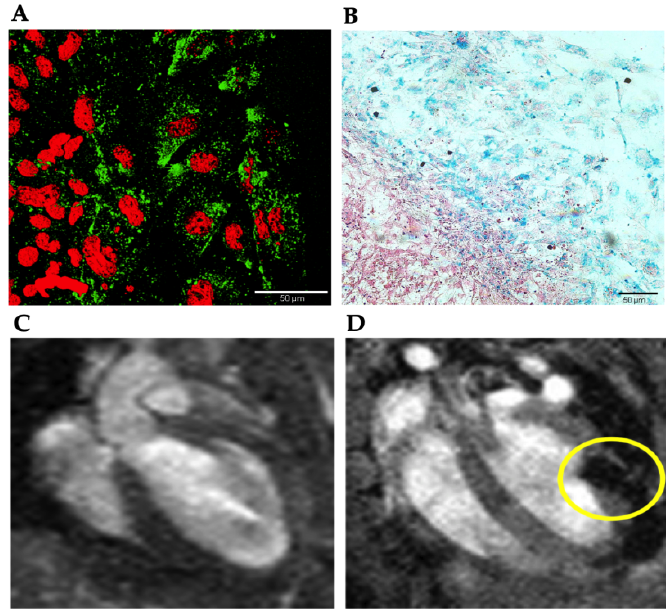
Figure 5. Detection of FeraTrack-labeled CM-mESC. ( A ) Micrograph showing anti-dextran (green) staining in labeled CM-mESC. The nuclei were labeled with Topro (red). ( B ) Iron from SPION particles is visible after the Prussian blue reaction. Representative images of in vivo MRI before ( C ) and 24 h after ( D ) cell transplantation. Yellow circle indicates the hypointense (black) spots corresponding to FeraTrack-labeled CM-mESC in the free left ventricular wall. No signal was detected before cell therapy. CM-mESC - cardiomyocytes derived from mouse embryonic stem cells, SPION - superparamagnetic iron oxide. Scale bar: 50 µm.